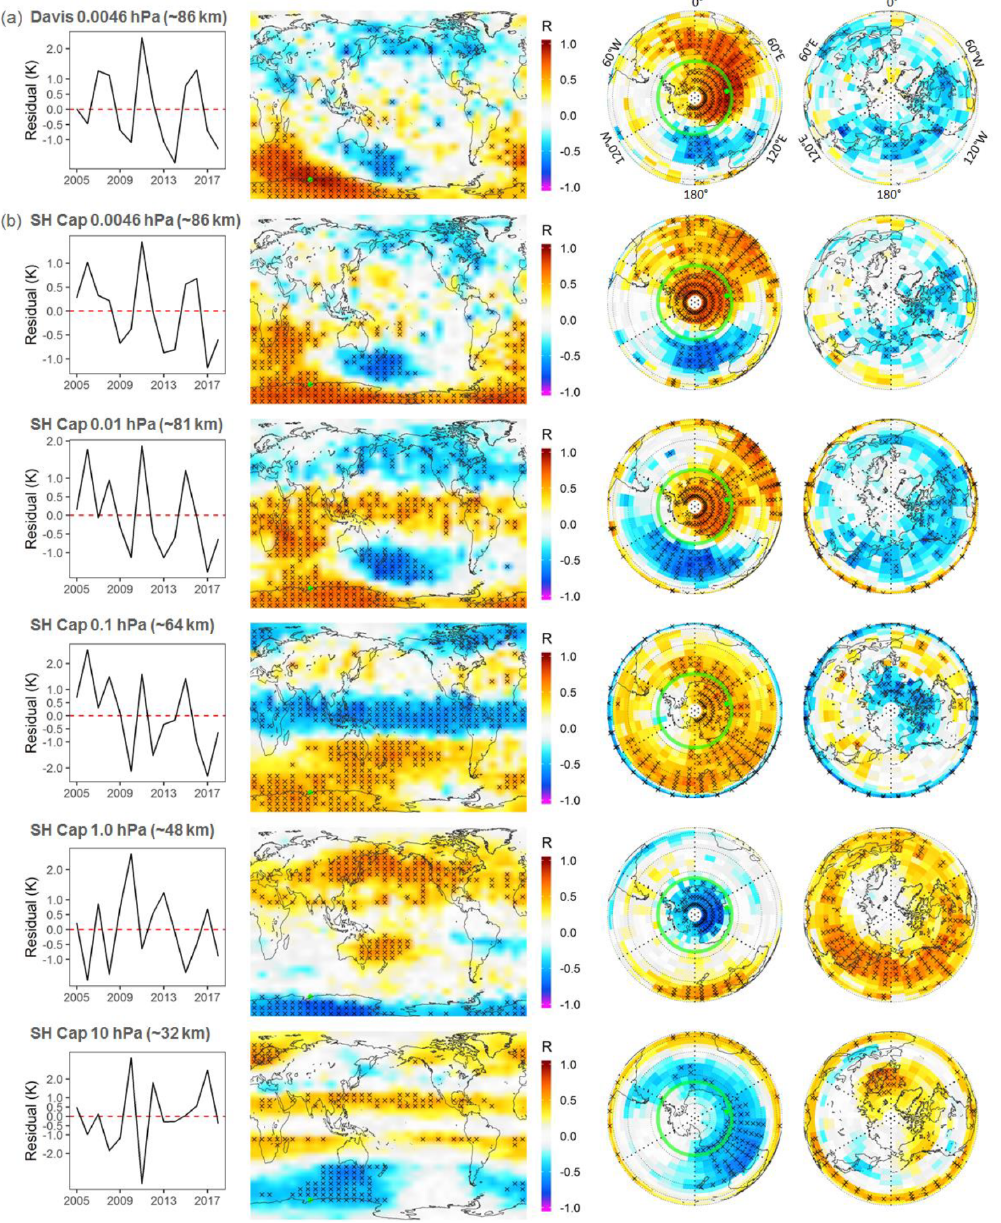
Figure 2. (a) Correlation of the Aura/MLS 0.0046hPa grid box QQO residual temperature signal at Davis (left-hand time series panel) with each grid box of the Aura/MLS 0.0046hPa global temperature field gridded in 5 ◦ × 10 ◦ bins. Equi-rectangular and polar projections of the correlation ( R ) are shown (crossed grid cells are significant at the 90% level). Davis location indicated by green dot. (b) Correlation of the 0.0046hPa SH polar cap winter average (65–85 ◦ S; AMJJAS; green circle) with each grid box of the Aura/MLS temperature fields at various pressure levels as